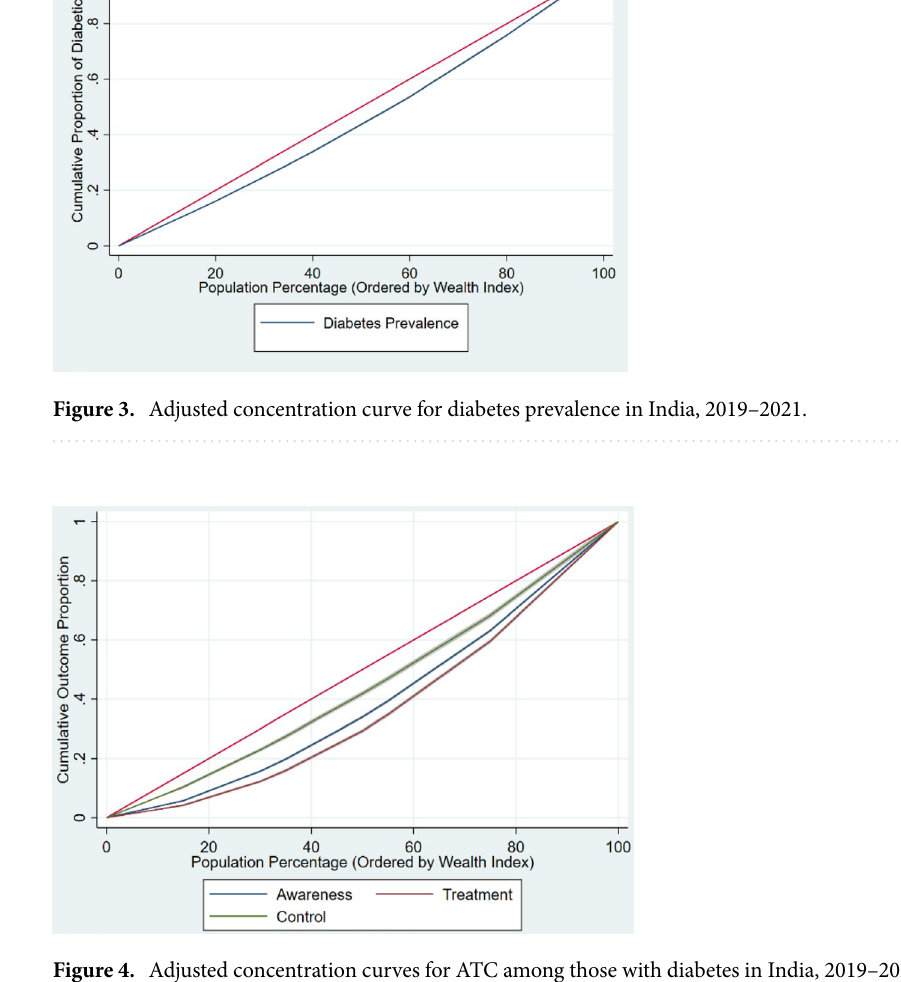
Figure 4. Adjusted concentration curves for ATC among those with diabetes in India,